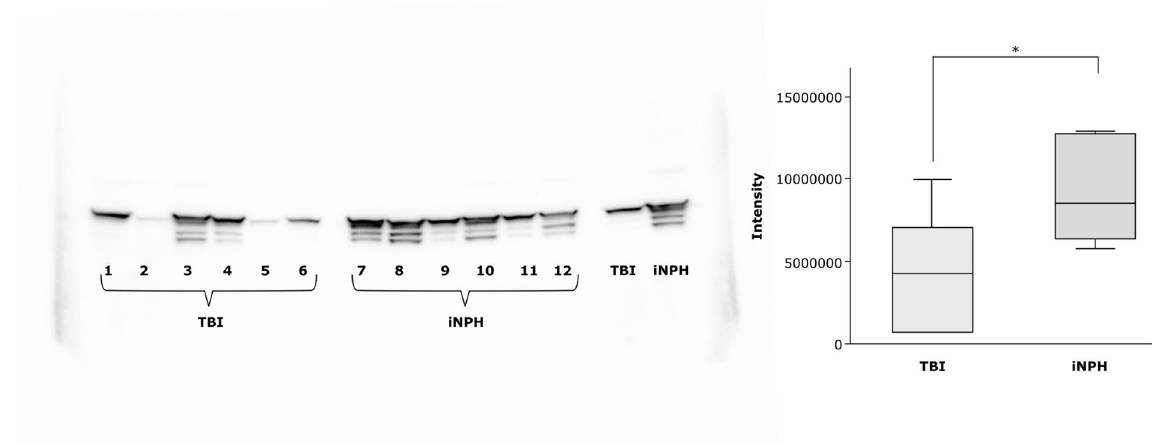
Figure 2. Validation of Glial fibrillary acidic protein (GFAP) expression in Study A by Western blot analysis in traumatic brain injury (TBI) vs idiopathic normal pressure hydrocephalus (iNPH) samples. The image shows individual samples from TBI patients (1–6), from iNPH patients (7–12) and pooled samples of TBI and iNPH patients respectively. Similar to the results from the MS-proteomic analyses, the level of GFAP was significantly ( * ) decreased in TBI as compared to iNPH ( p =